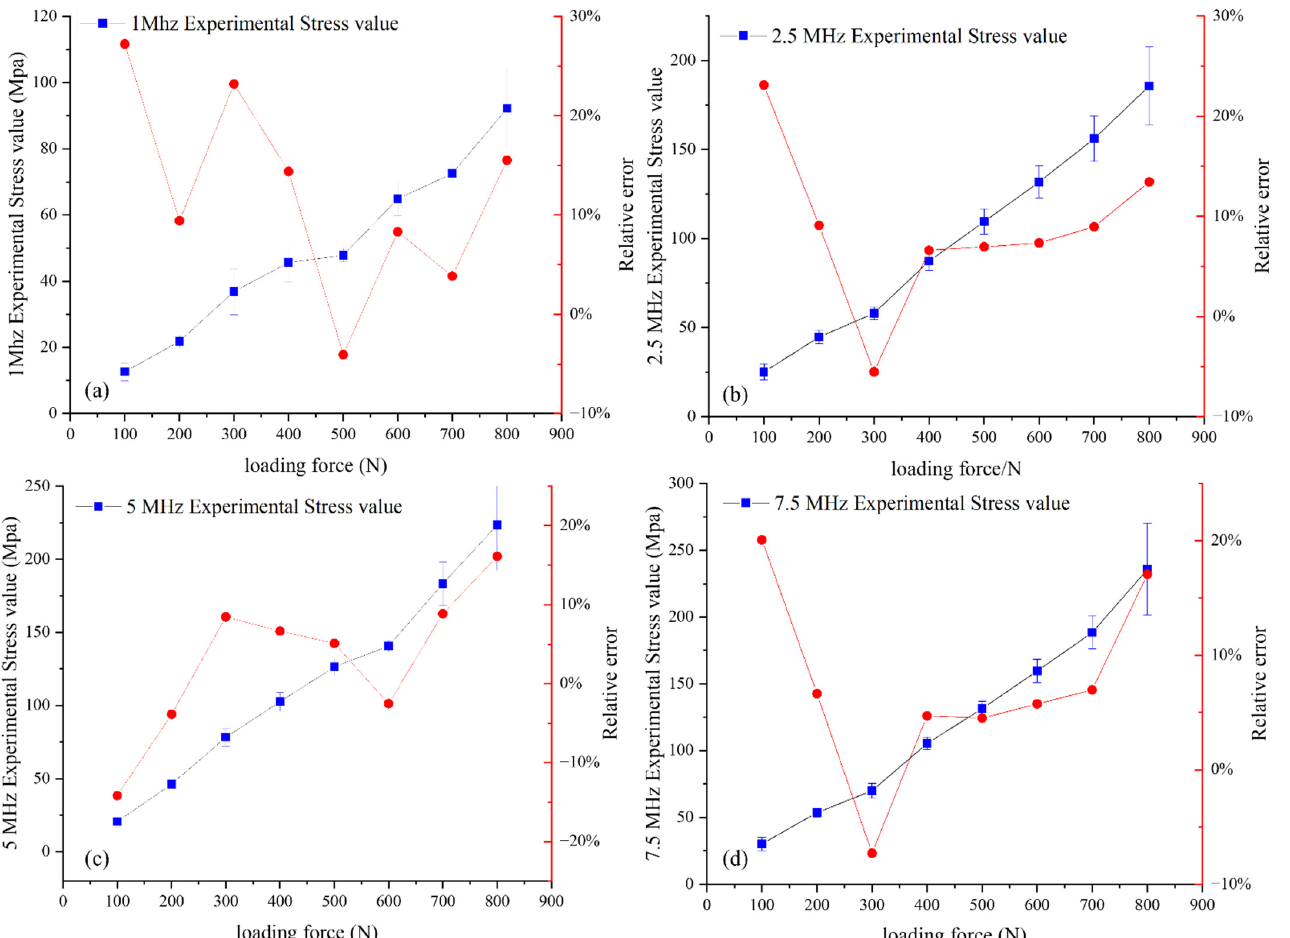
Figure 13. Comparison of theoretical stress and detection values at different detection depths: ( a ) F = 100 N; ( b ) F = 300 N; ( c ) F = 500 N; ( d ) F = 700 N.